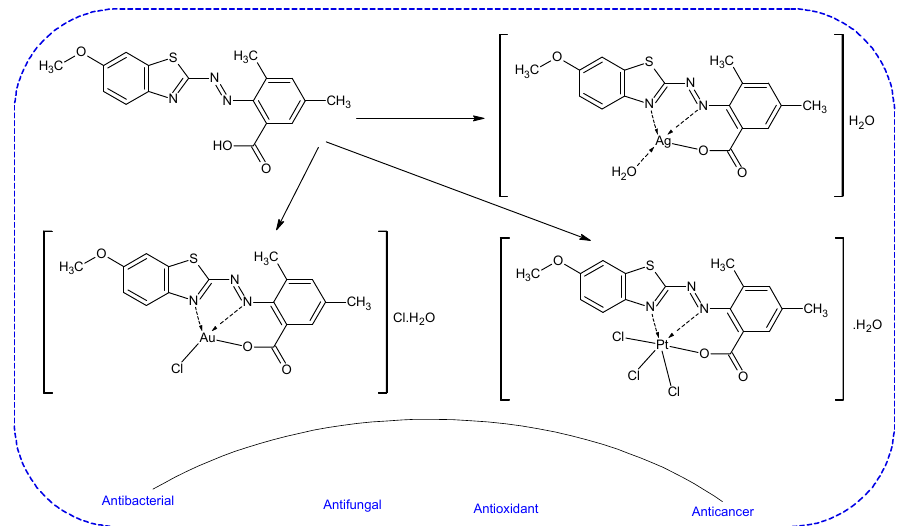
Scheme 1. The structures of azo-derived metal complexes with its featuring biological activity (from Ref.